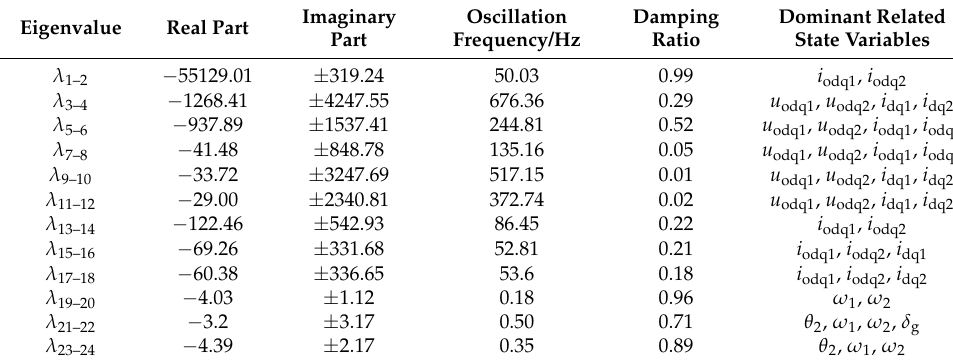
Table 6. Multi-VSG system